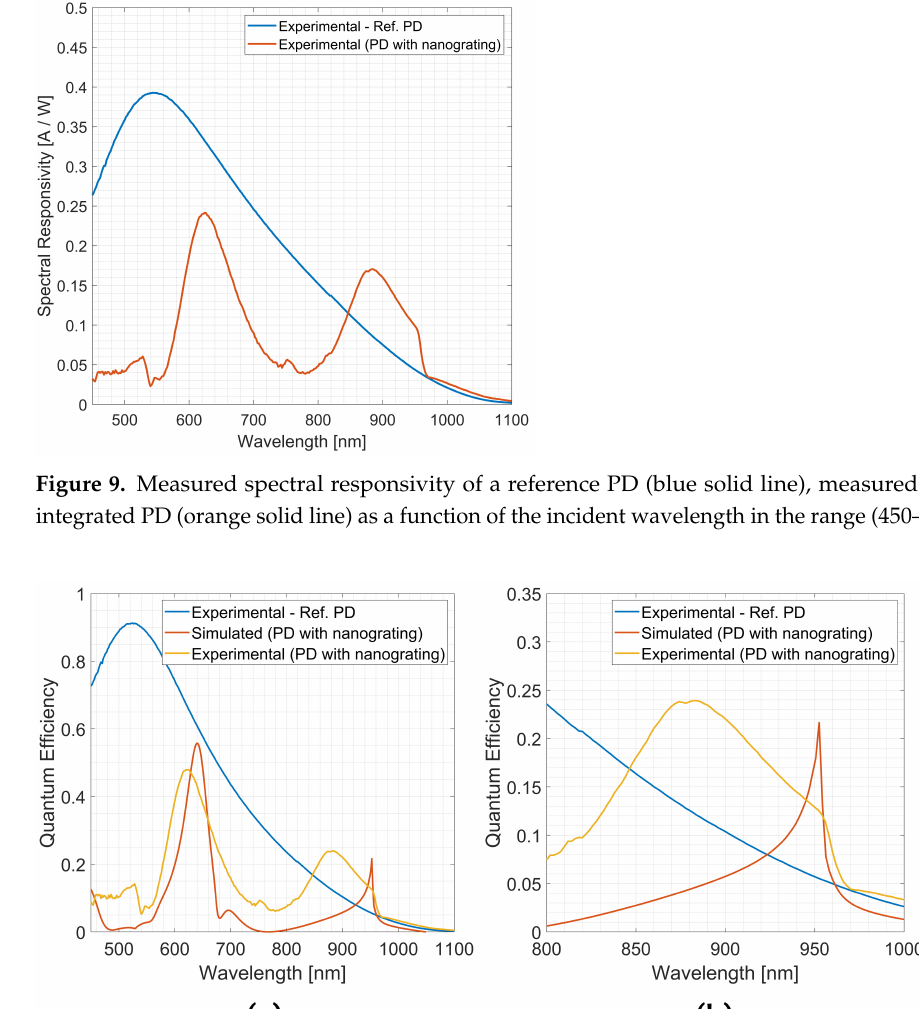
Figure 10. Measured QE of a reference PD (blue solid line), a fraction of absorbed light of the simulated structures (orange solid line) and measured QE of the integrated PD (yellow solid line) as a function of the incident wavelength in the range: (a) (450 - 1100) nm and (b) (800 - 1000) nm. Both simulated and QE of the integrated PD are lower than the QE curve of the reference at almost every wavelength except in the range around the wavelength of our interested 950nm.